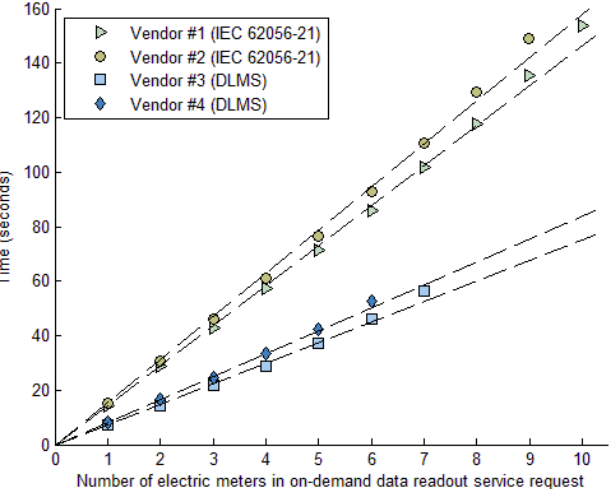
Figure 8. Averaged time of on-demand readout command execution performed on a unified group of vendor-type specific EMs connected to single LMCs.